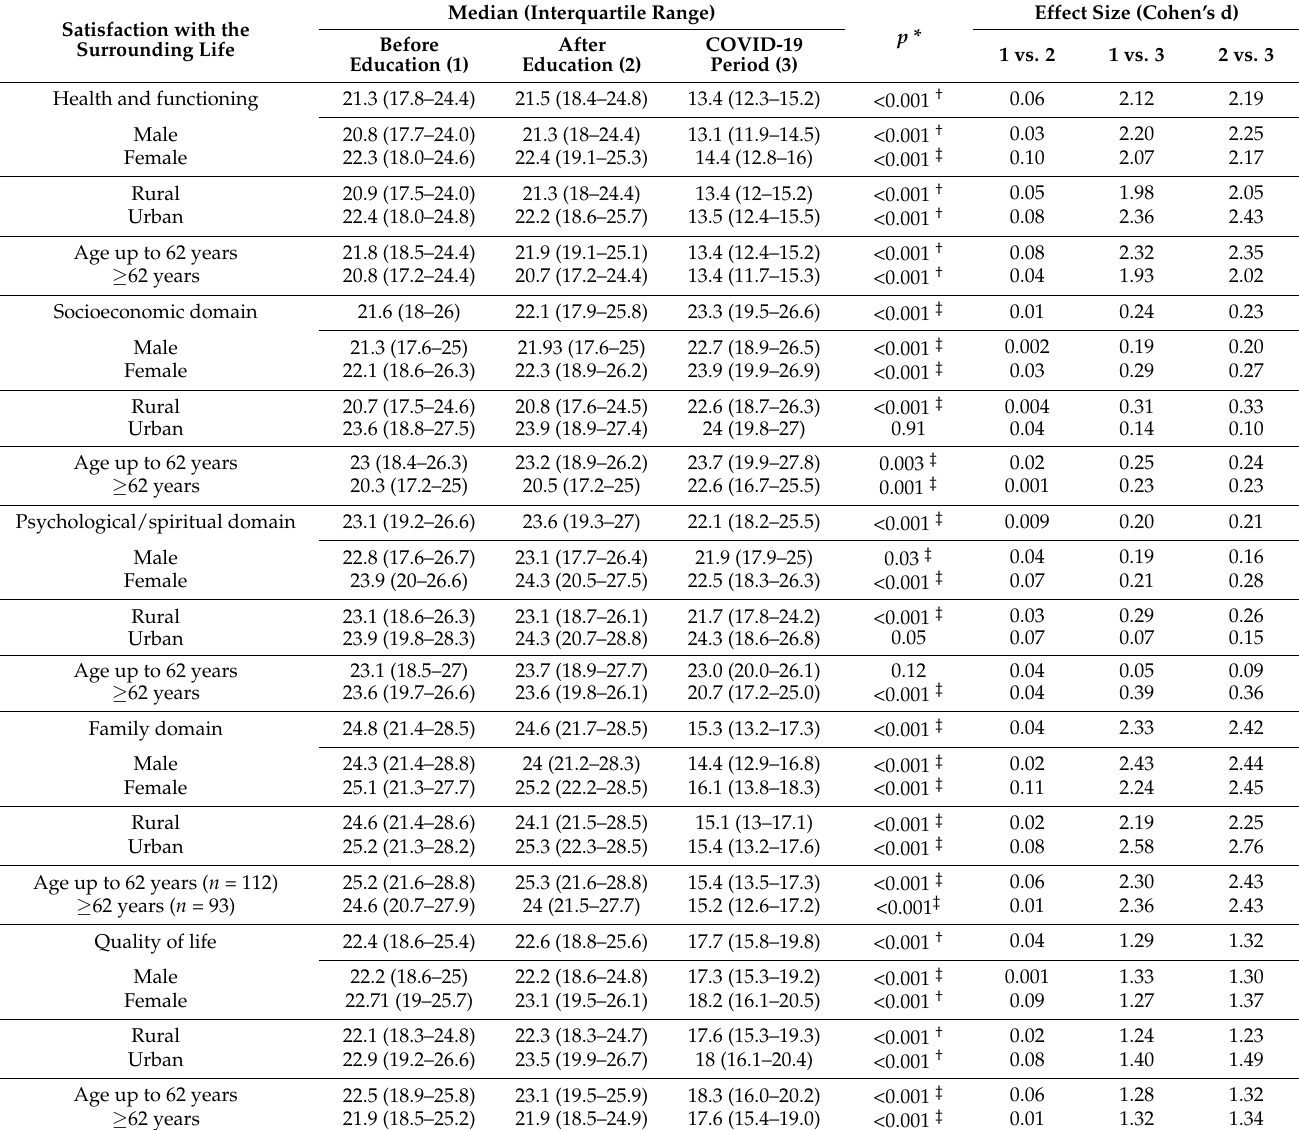
Table 3. Quality of life by domains before/after education and in the COVID-19 period, and differences with regard to gender, place of residence and